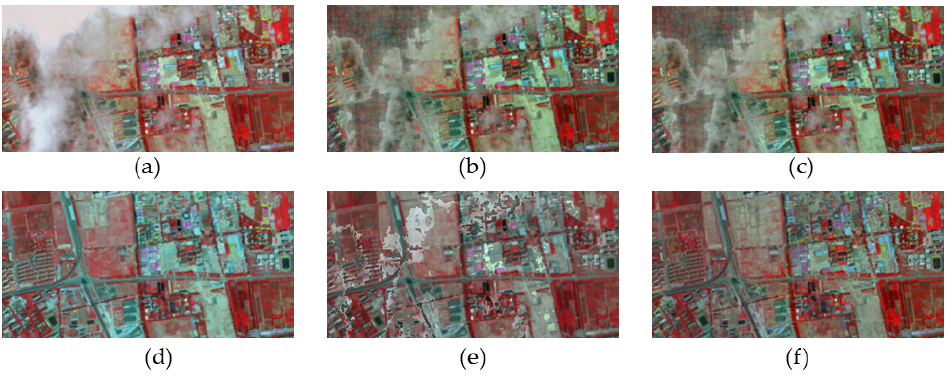
Figure 19. ( a – f ) Detailed regions clipped from Figure 18a–f. Table 6. The SD, FD, IE, BIQME, and PAQ-2-PiQ of the second real-data experimental results. The values of the highest accuracies are in